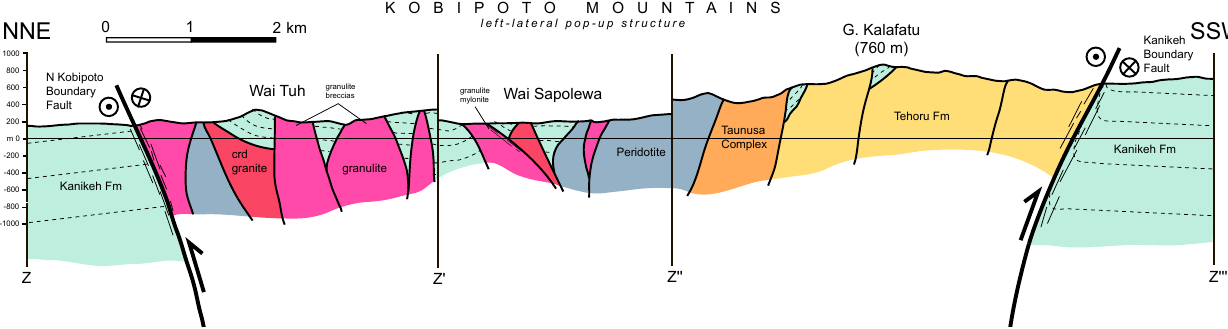
Fig. 15. Semi-schematic cross section through the Kobipoto Mountains following profile Z–Z 0 –Z 00 –Z 000 as shown on the geological map in Fig. 14. All marked faults are interpreted to have had dominantly left-lateral strike-slip senses of motion that have exhumed the Kobipoto and Taunusa/Tehoru Complex rocks within the Kobipoto Mountains positive flower